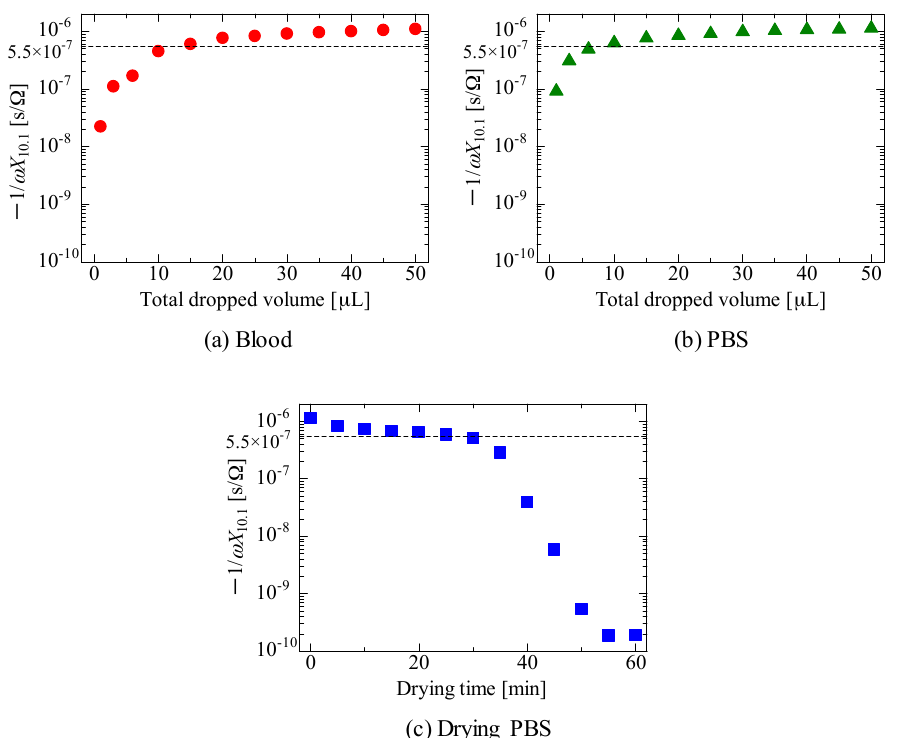
Figure 7. Values of − 1/ ω X 10.1 of the sensor as a function of the total volume of ( a ) blood or ( b ) PBS dropped. The dependence of the − 1/ ω X 10.1 of the sensor in which a total volume of 50 µ L of PBS was dropped on the drying time is shown in ( c ). The assumed threshold value (5.5 × 10 − 7 s/ Ω ) is indicated as a visual guide.